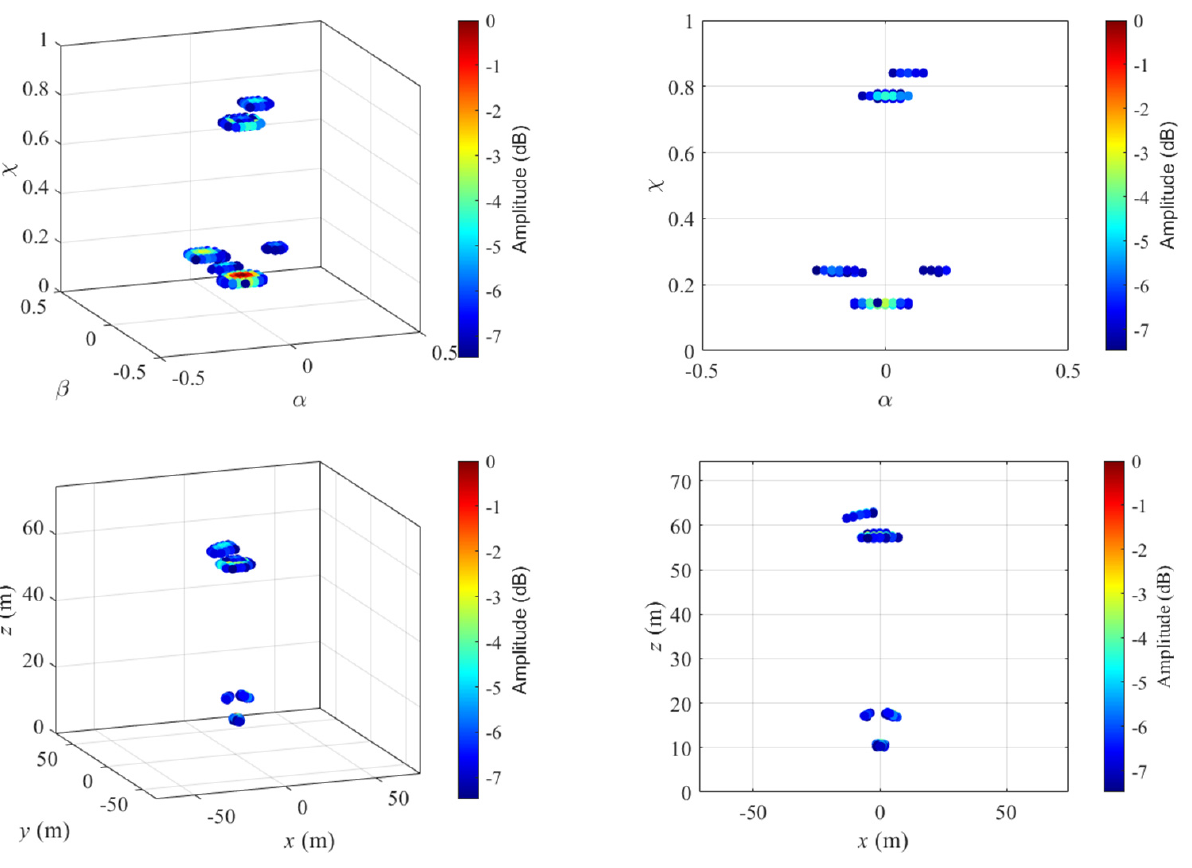
Figure 30. Real target imaging results obtained by the 3D IFFT in (top) the α - β - χ domain and (bottom) the x-y-z domain.